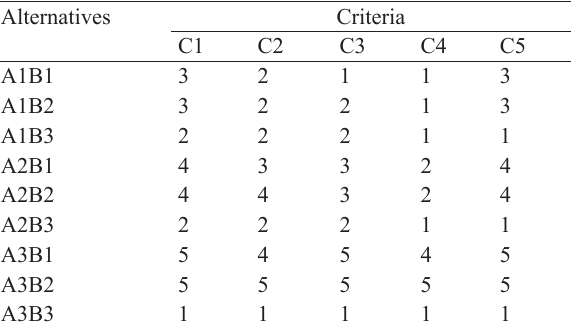
Table 8 Matrix of experts’ assessment on alternatives